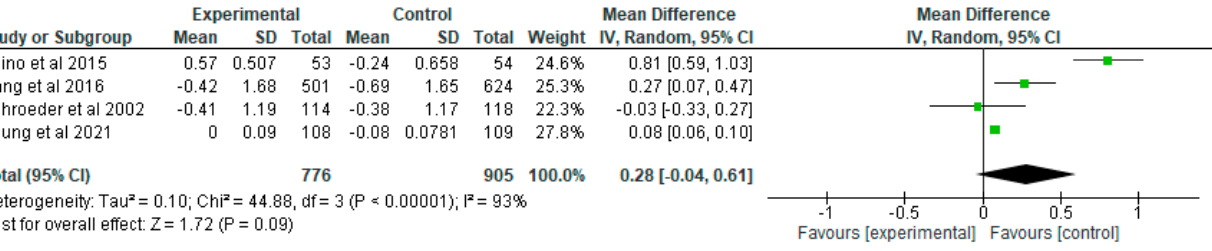
Figure 5. Results pooled data on the e ff ect of positive deviance interventions on WAZ [28–31]. 3.4.3. E ff ect of Positive Deviance-Based Interventions on Weight for Height Z-Score (WHZ)